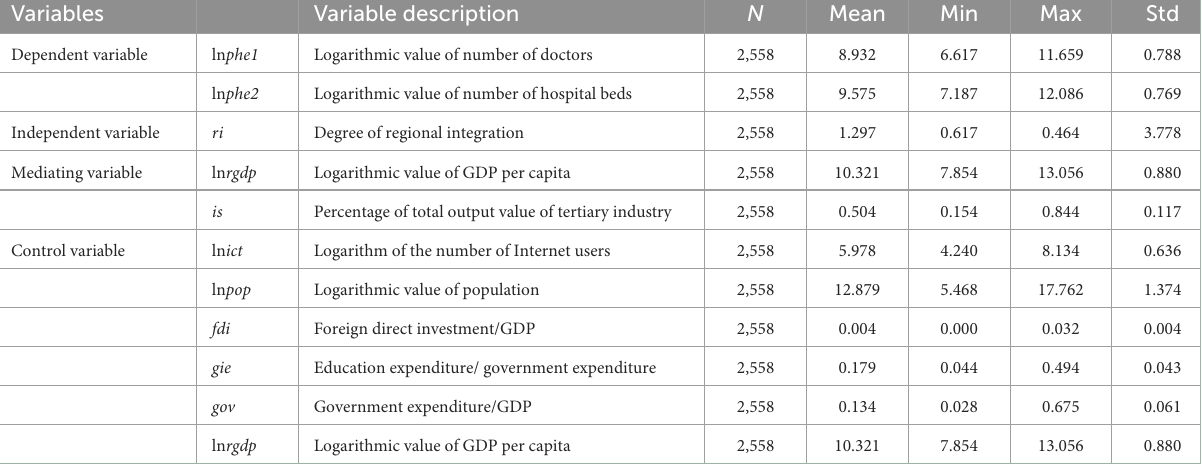
TABLE 1 Descriptive statistics.